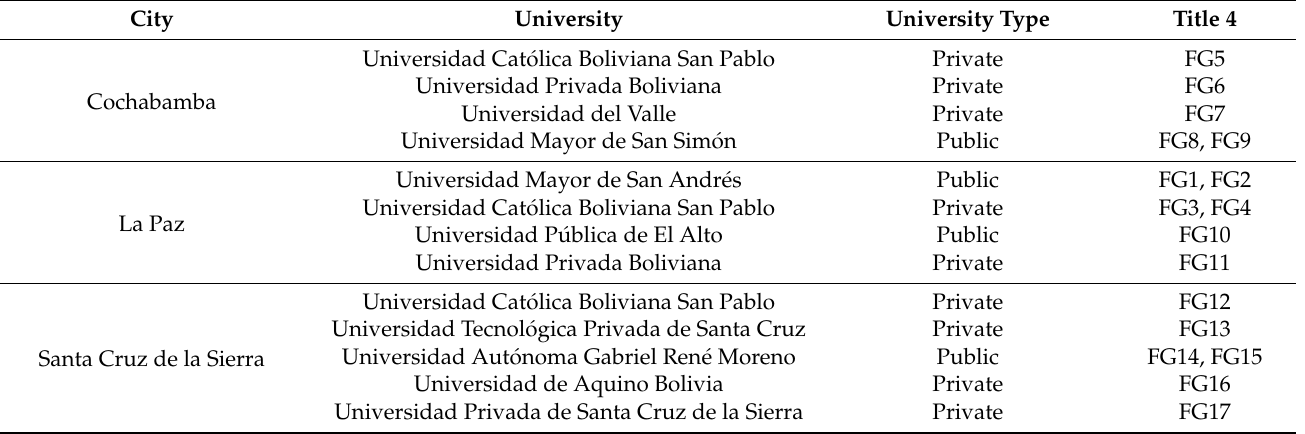
Table 1. Overview of the research